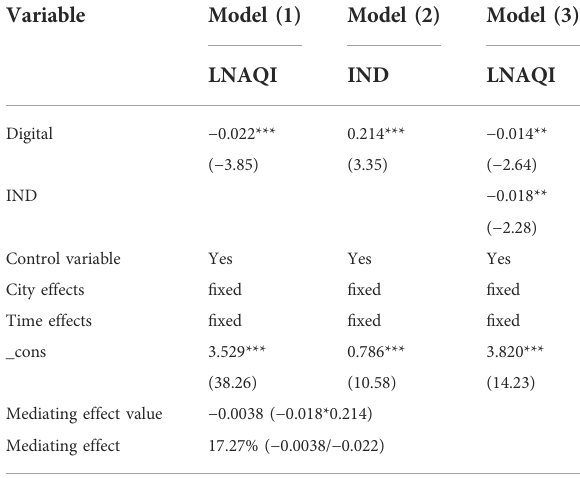
TABLE 3 Test results of the mediating effect of the industrial structure advancement.